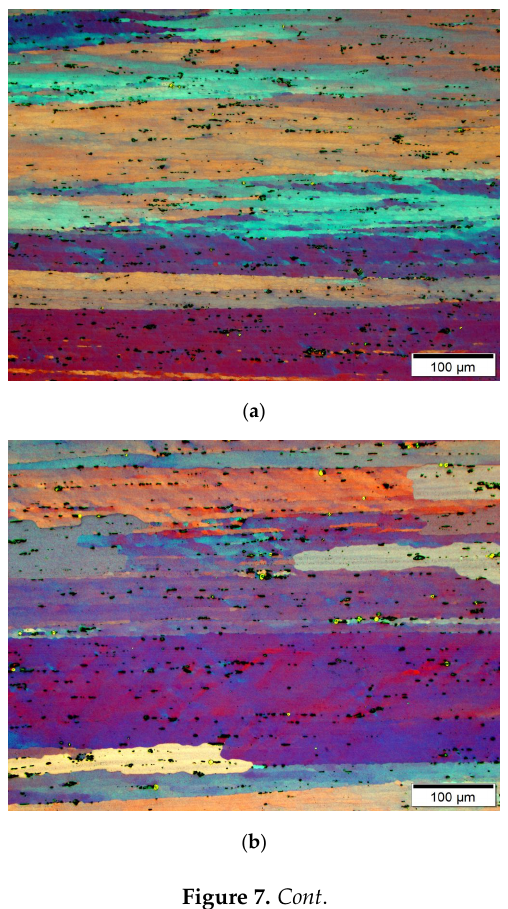
Figure 6. Basquin’s characteristics of regression lines with confidence interval ( α = 0.05)